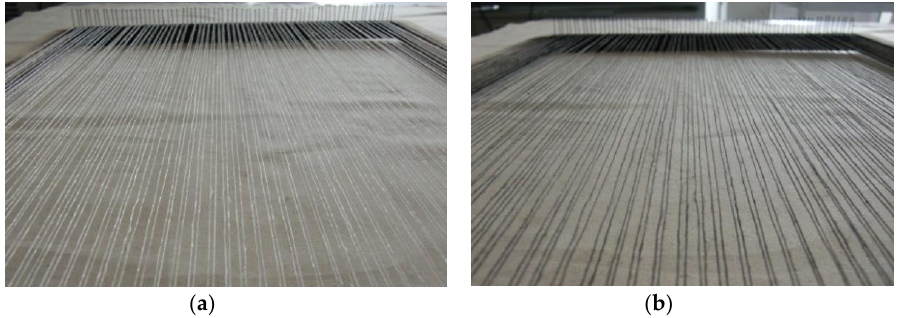
Figure 3. Composite copper / cotton yarn before; ( a ) and after; ( b ) colouration.